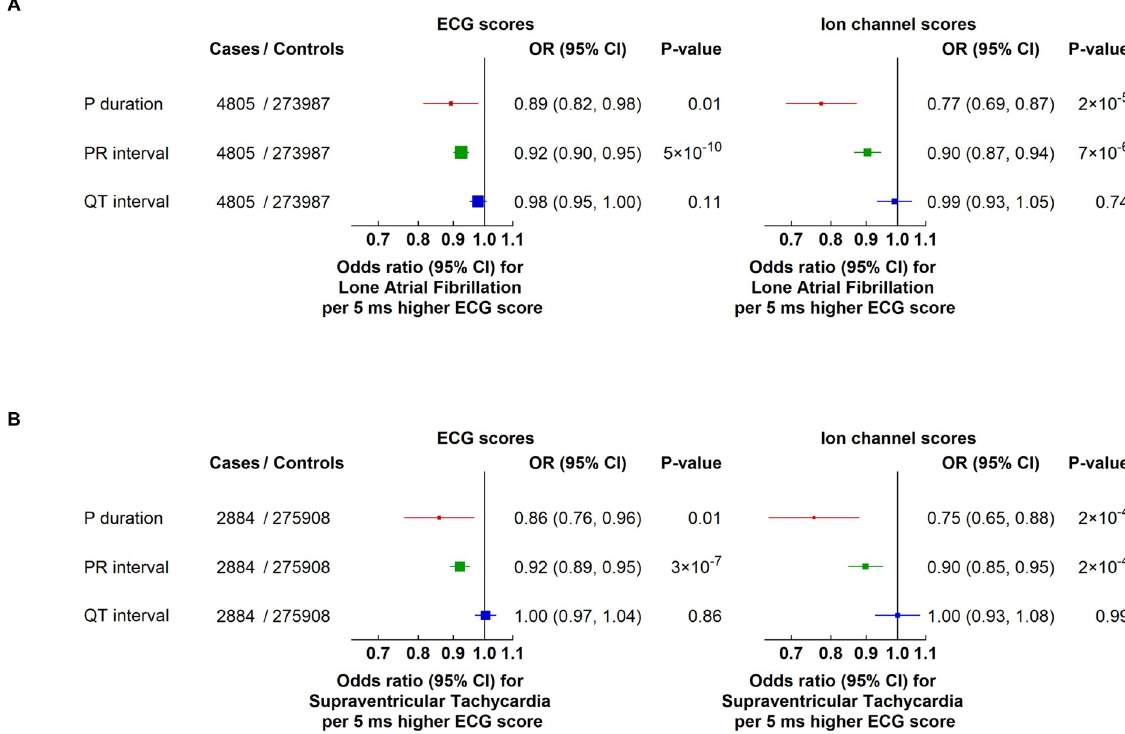
Fig 3. Effects of genetically predicted ECG parameters on the risk of lone AF and SVT in UK Biobank. Effects of genetically predicted ECG parameters on risk of (A). “Lone” AF and (B). SVTs in UK Biobank. Ion channel scores for each ECG parameter include only genetic variants annotated to known ion channel genes. Boxes represent point estimates of effect per 5 ms higher ECG score with sizes inversely proportional to their variance, and lines represent 95% CIs. ORs are adjusted for genotyping array, sex, and 40 principal components of ancestry. AF, atrial fibrillation; CI, confidence interval; ECG, electrocardiographic; OR, odds ratio; SVT, supraventricular tachycardia.